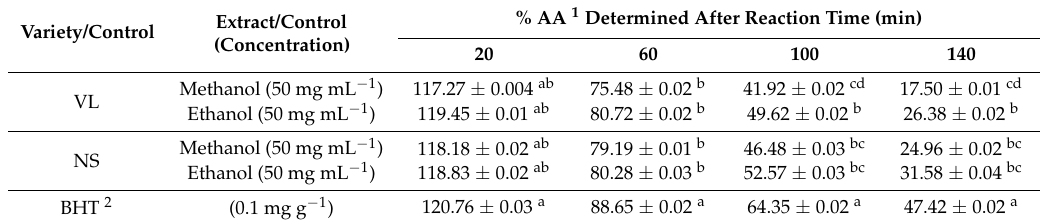
Table 5. Percentage antioxidant activity (AA) of extracts of fruit from Sechium edule var . virens levis (VL) and S. edule var . nigrum spinosum (NS) as determined by the β -carotene-linoleic acid test.